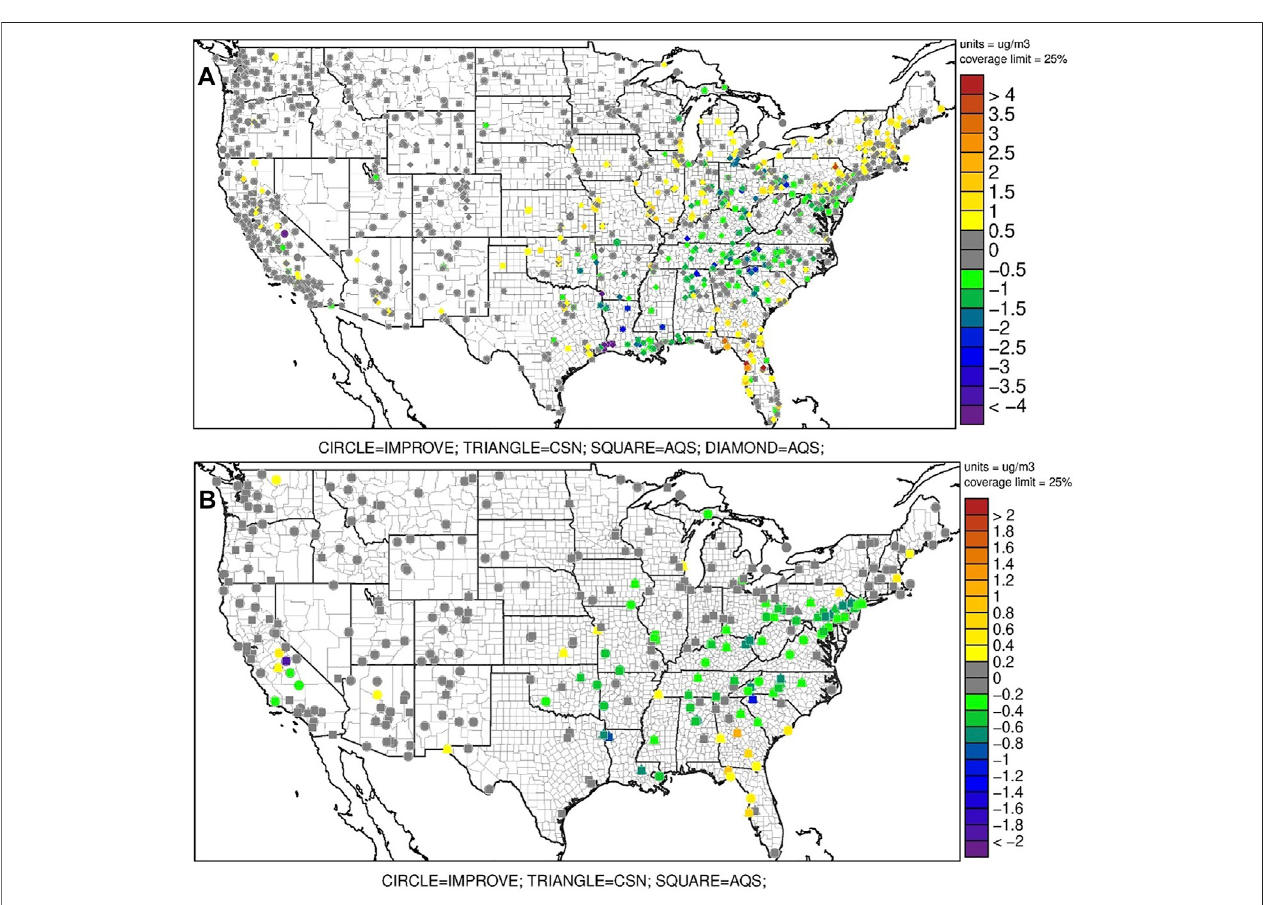
FIGURE 1 | Changes in model errors between Base_14 and UpTk_14 for (A) PM 2.5 and (B) OC at each observation site. Negative values indicate reduced model errors in UpTk_14 compares to Base-14. For (A) , the SQUARE (AQS sites) only records daily mean value, the DIAMOND (AQS sites) records hourly data.